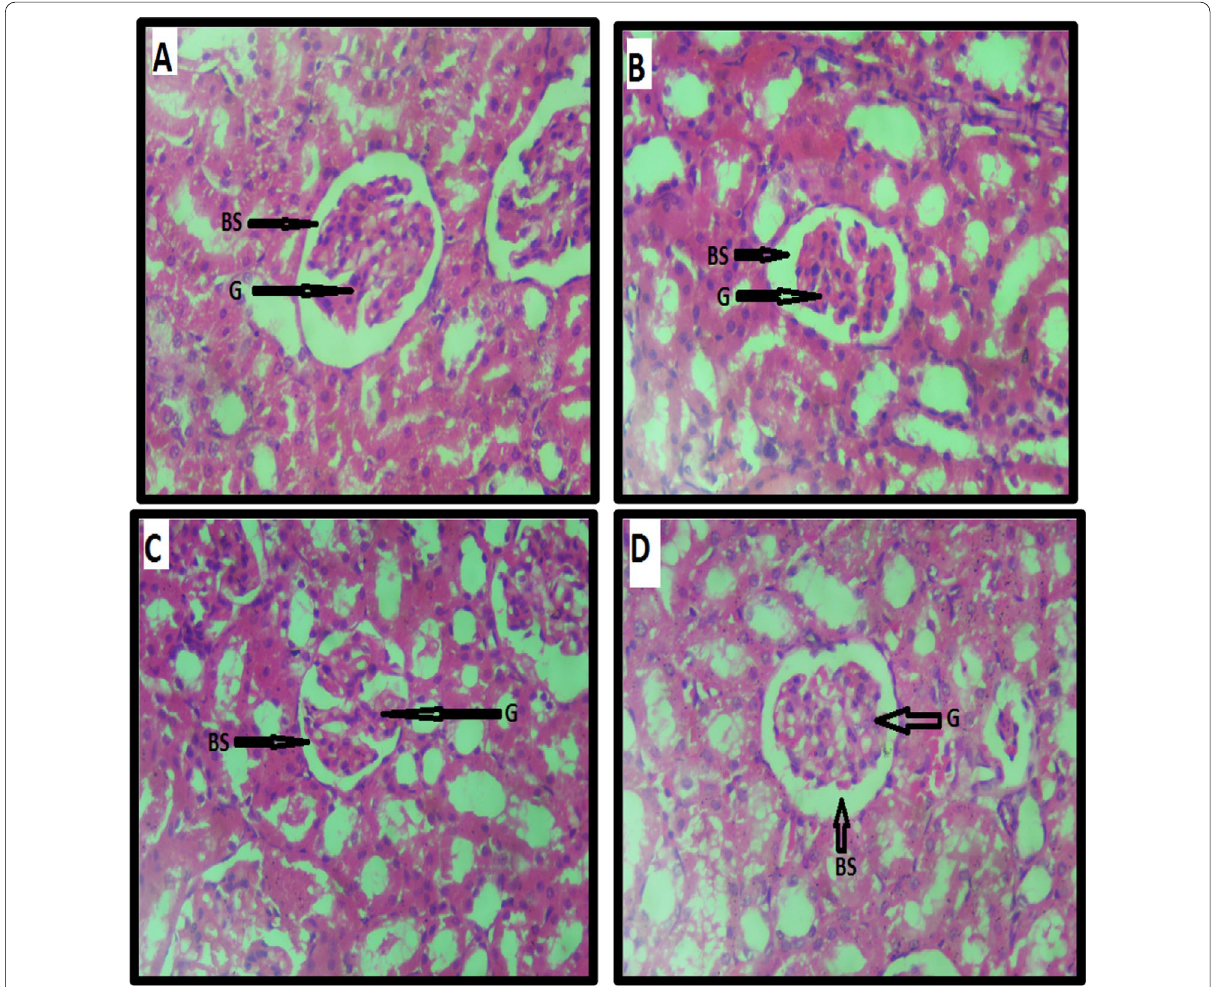
Fig. 5 Kidney sections (H&E stained) (200X) of A control rats, B chloroform extract treated rats, C ethanol extract treated rats and D n-hexane extract treated rats after 14 days. BS bowman’s space, G